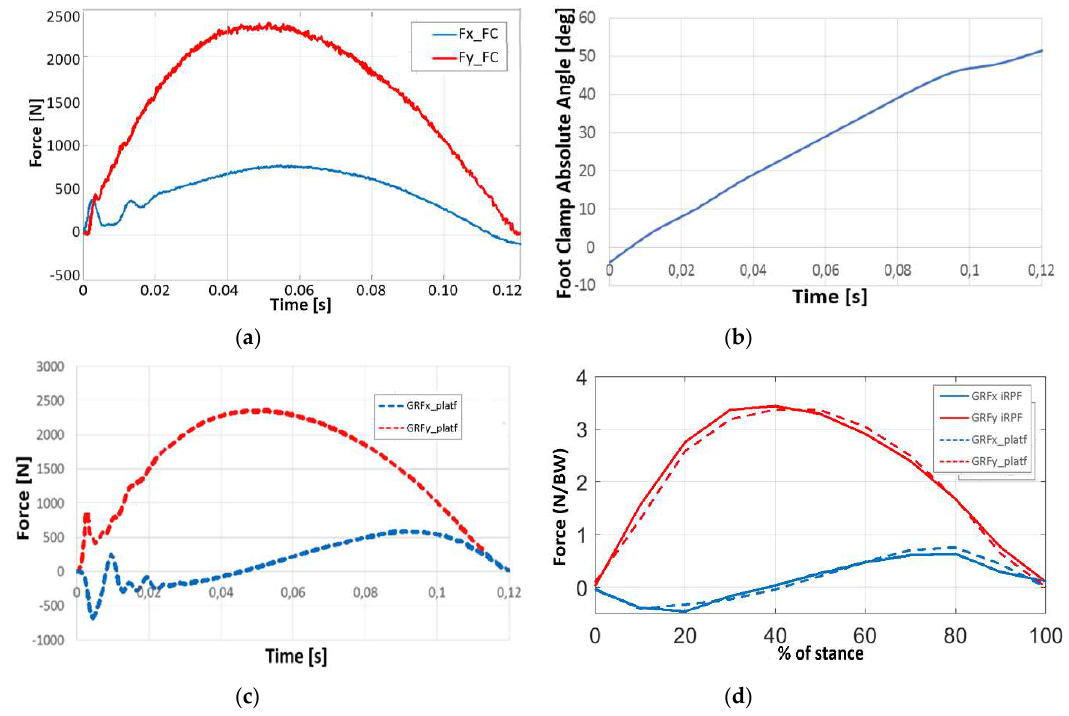
Figure 11. Validation of the Ossur iRPF, by comparison of GRF measured with the Force Platform and with the iRPF during a running test of athlete TT1: ( a ) force components in the Foot Clamp reference system, collected from the iRPF; ( b ) absolute orientation angle of the Foot Clamp reference system obtained by the high-speed camera during the step over the force platform; ( c ) GRF measured by the Kistler force platform at the passage of the athlete; and ( d ) comparison of X and Y GRF components between the force platform measurement (dotted) and the iRPF loads (solid) resolved in the Global Reference System (GRS) normalized to the stance interval and to athlete’s weight.